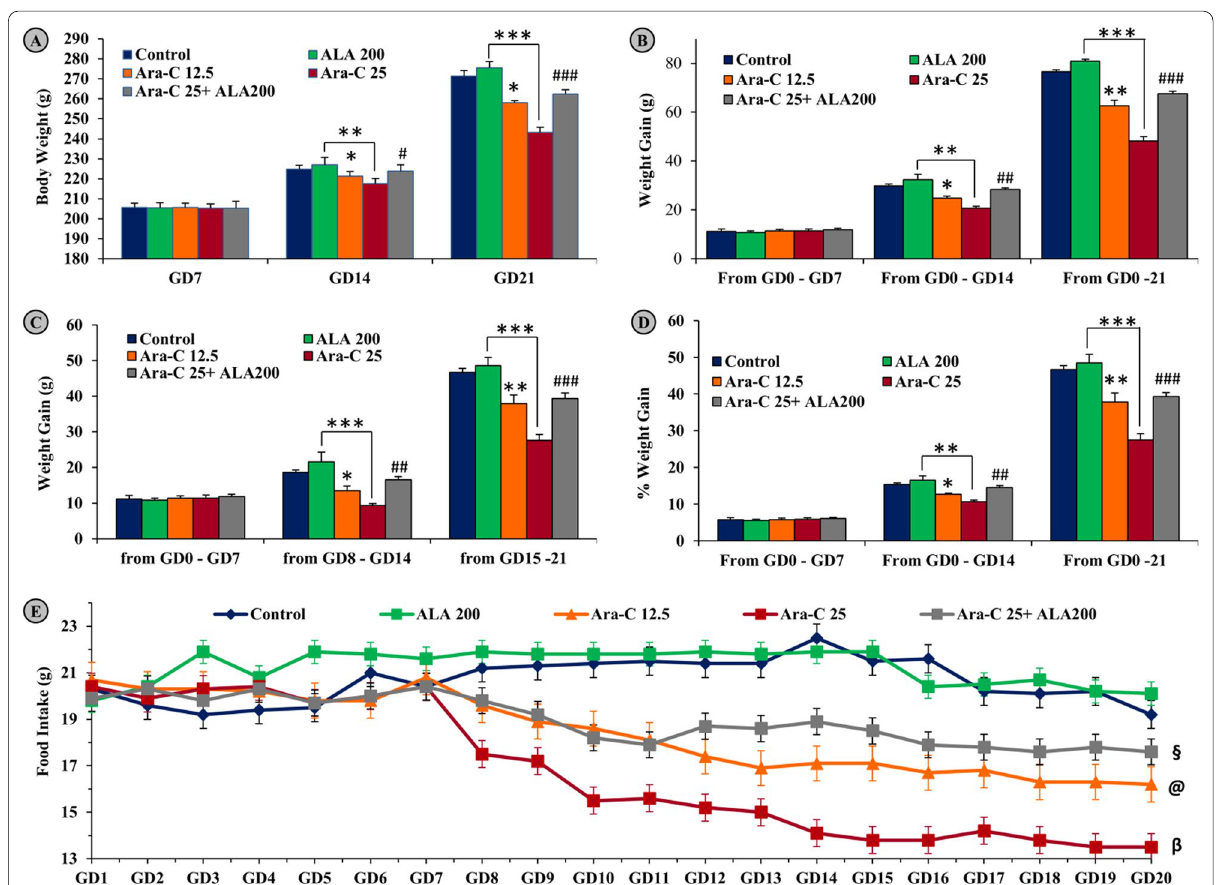
Fig. 1 Effect of Ara-C and ALA on maternal A bodyweight, B weight gain, C weekly bodyweight gain, D %weight gain, and E food intake. All the values are expressed as mean SEM, (n 6). *** P < 0.001 versus control, ** P < 0.01 versus control, * P < 0.05 versus control; ### P < 0.001 versus Ara-C ± = 25 mg/kg, ### P < 0.01 versus Ara-C 25 mg/kg, # P < 0.05 versus Ara-C 25 mg/kg; For food intake, β, P < 0.001 versus control, @ P < 0.001 versus control); § P < 0.001 versus Ara-C 25 mg/kg. ALA alpha-lipoic acid, Ara-C cytarabine, GD gestation day, g